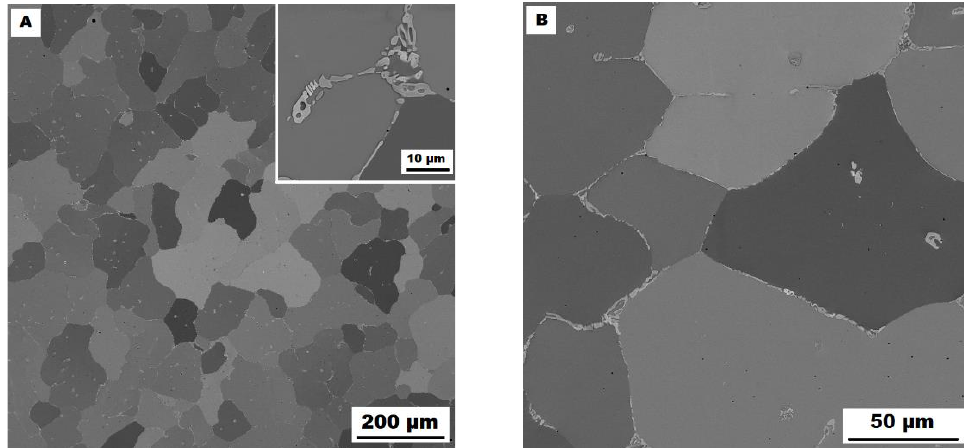
Figure 3. XRD diffractograms of investigated alloys in the as-cast state.